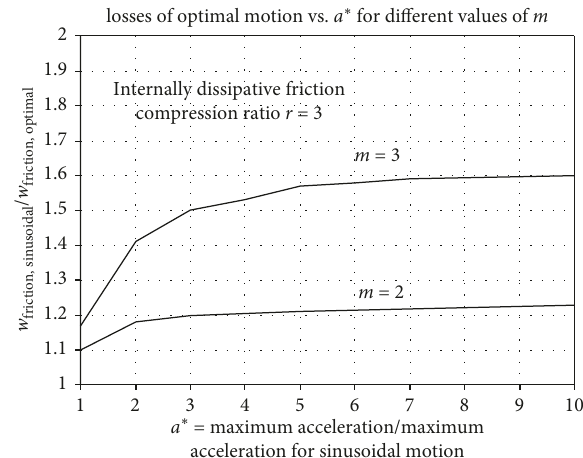
Figure 10: Sensitivity of reduction in frictional losses to maximum piston acceleration. Ordinate is dynamic frictional losses for conventional piston motion relative to that for optimal piston motion, for internally dissipative friction. Abscissa is maximum piston acceleration relative to its maximum value for the con- ventional trajectory. The two curves are for different frictional exponents m and show the marked dependence on m